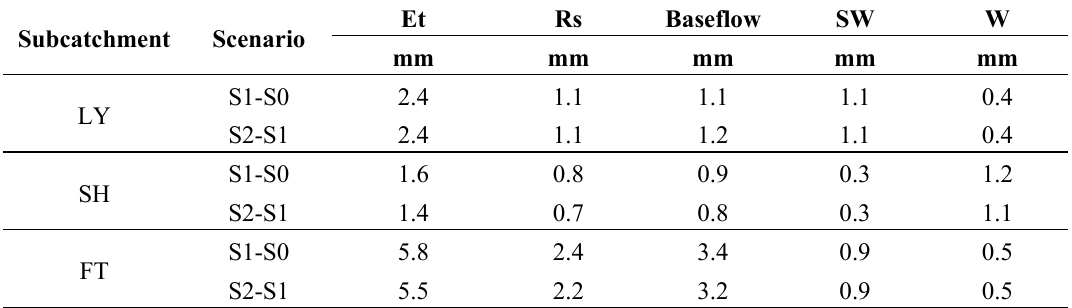
Table 10. Real change of the hydrological elements under different land use